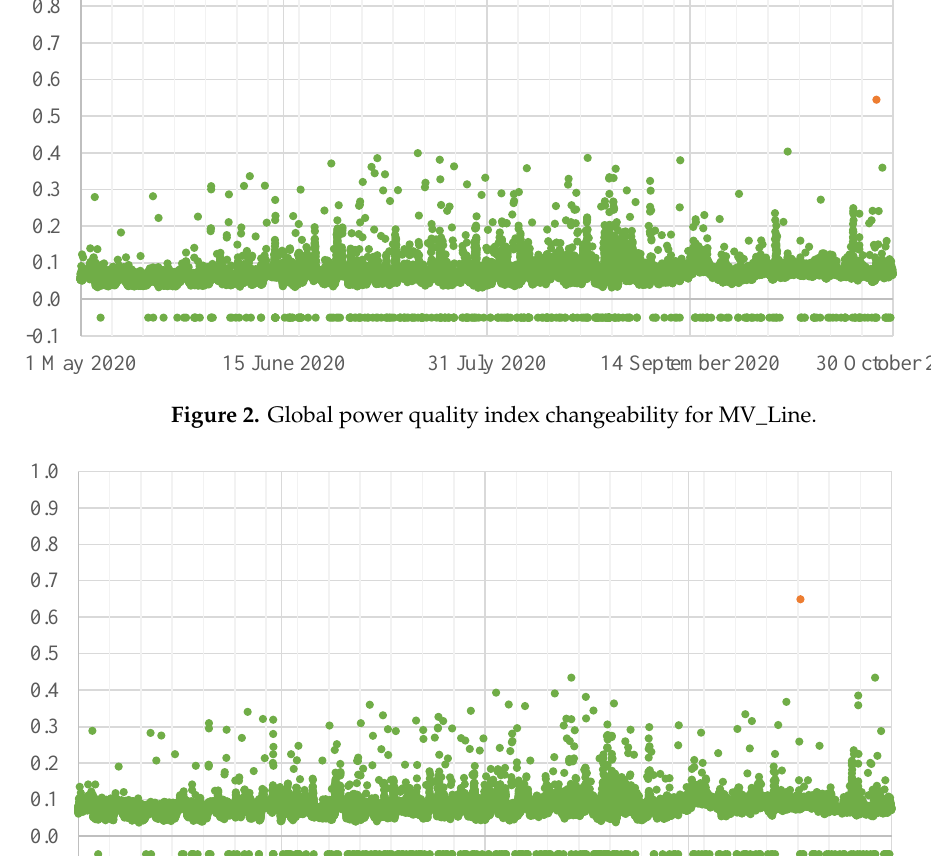
Figure 5. Global power quality index changeability for LV_L. During the time domain change in ADI level in LV_HE, a specific period was selected. In long- term assessment, it is challenging to verify the phenomena of this working condition. Therefore, the time shortage to 4 days that were connected with this working condition is presented in Figure 6. It can be observed that the PQ problem is noticed only in LV_HE, so this working condition is not connected with the impact of VPP. However, it is worth noticing that after a continuous (even linear) increase in ADI, a long event time in the LV_HE measurement point was indicated. In this article, in depth analysis of the reason for this working condition is omitted but this is a very interesting topic for future research.